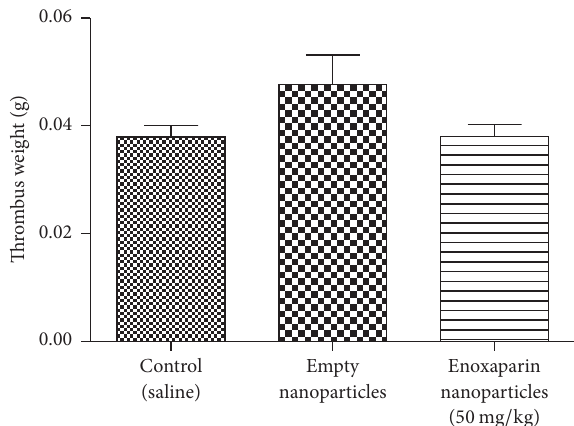
Figure 5: Comparison of thrombus weight in animals after surgery and oral treatment. 𝑁 = 6 animals per group. 𝑃 value calculated through